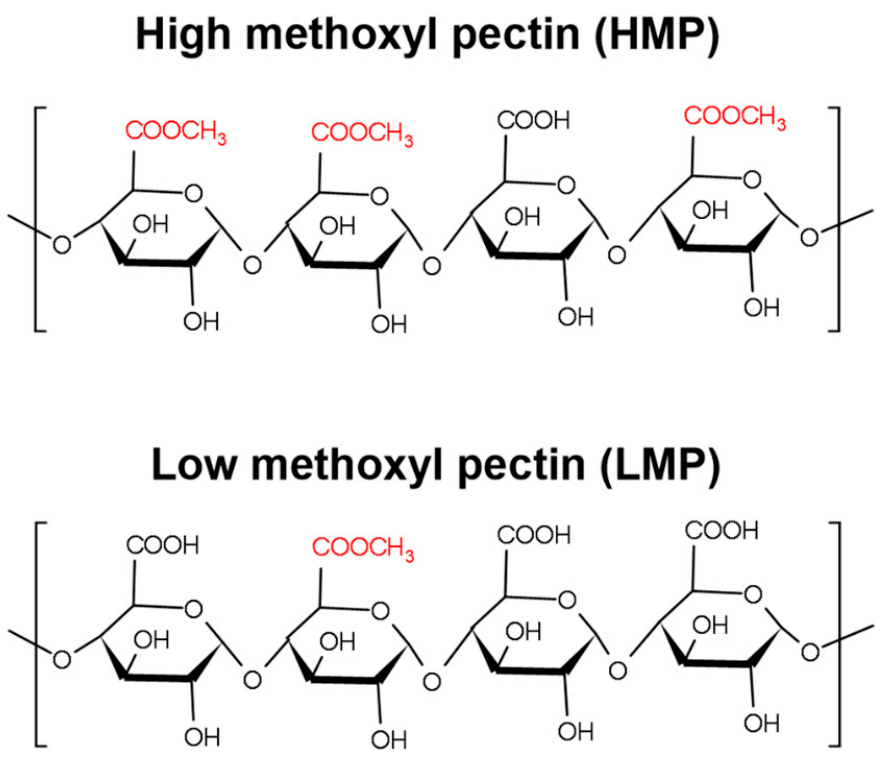
Figure 1. Scheme of the chemical structure of the heteropolysaccharide pectin indicating differences in the degree of esterification (DE). For chemical structure KingDraw 2.1 was used.